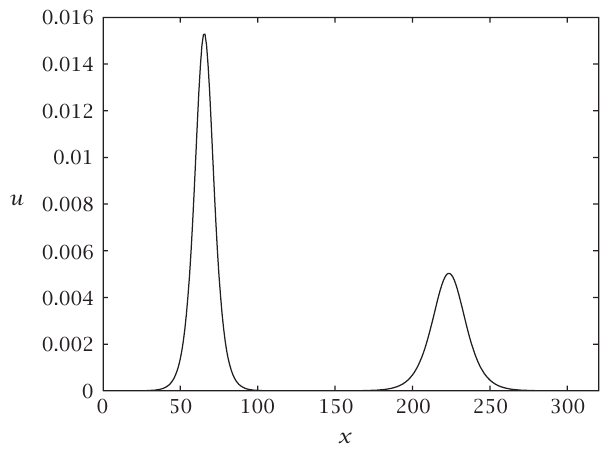
Figure 5.3. Initial conditions for two unequal-amplitude solitary